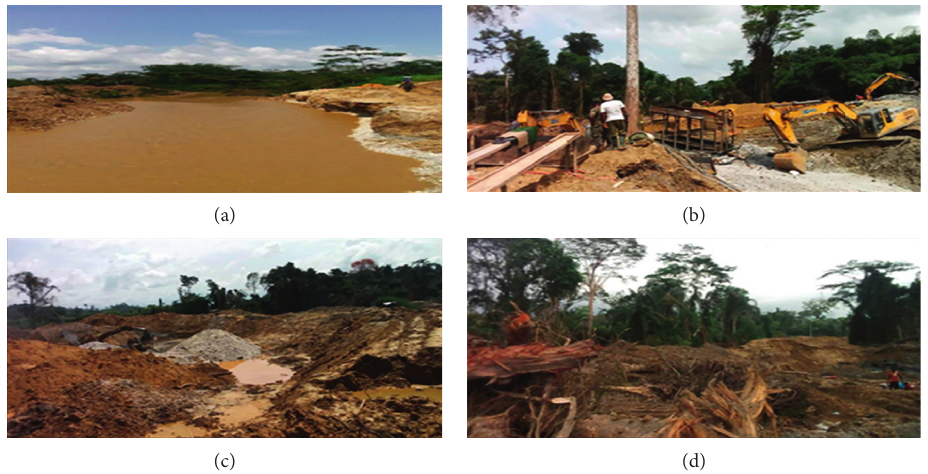
Figure 5: Scene of the prospecting area in Fure River Forest Reserve GSBA turned into surface